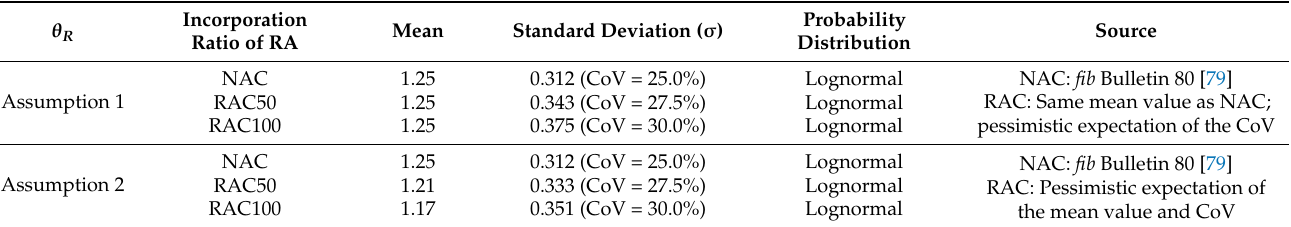
Table 7. Stochastic modelling of the model uncertainty of elements with shear reinforcement.